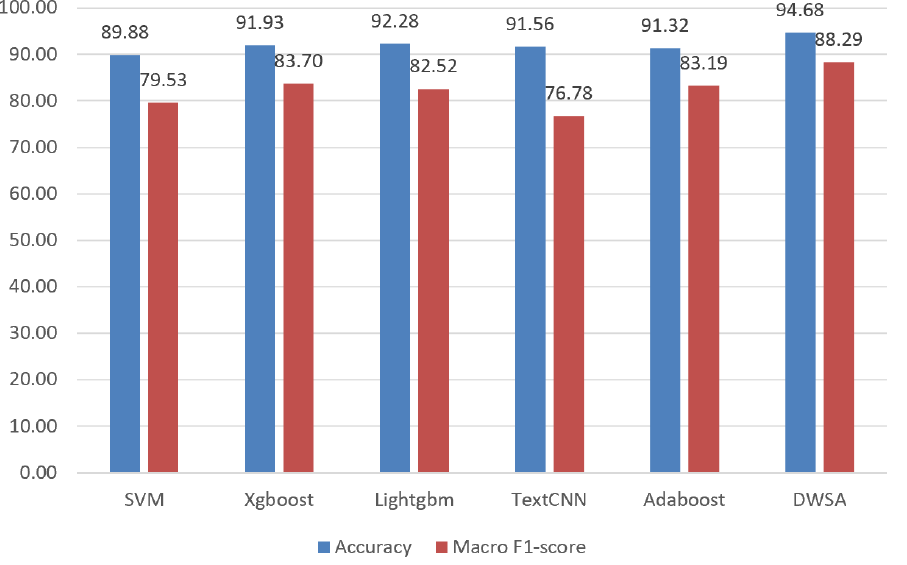
Figure 5. The result of the algorithm comparison experiment on the insurance data set. Accuracy and Macro F1-score are used to evaluate different algorithms. The proposed DWSA has the accuracy of 94.68% (3.36% absolute improvement over Adaboost) and the F1-score of 88.29% (5.1% absolute improvement over